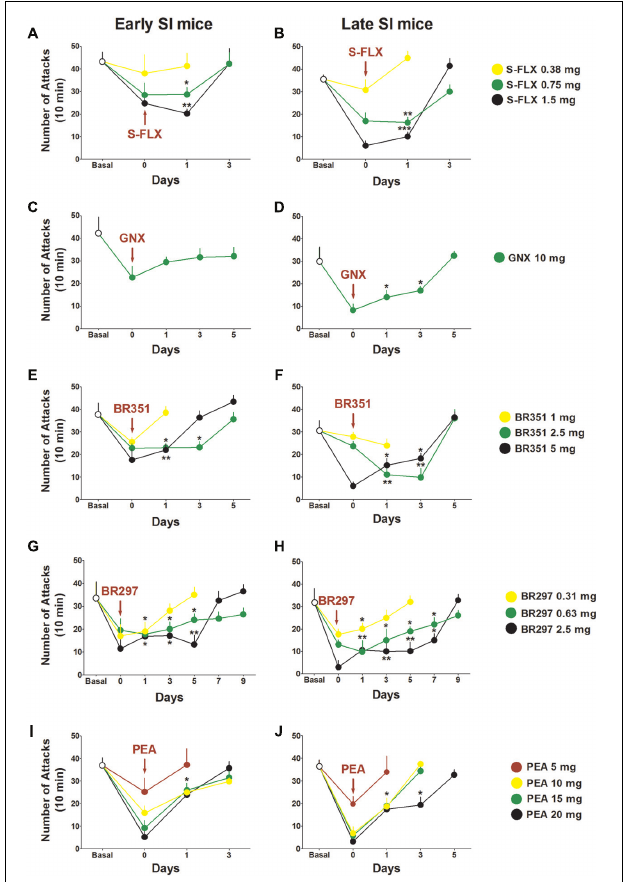
FIGURE 6 | Drug-induced time-dependent anti-aggressive effect in late and early adolescent SI mice. Graphs represent the gradual reinstatement of aggressive behavior both in early (A) and late (B) adolescent SI mice during the period following the single dose administration of S -FLX (Day 0). Aggression rapidly rebounded after 3 days from S -FLX administration in both groups of mice. After an EC 50 dose of GNX aggressive behavior rebounded to basal values only after 1 day in early adolescent (C) SI mice and after 5 days in late adolescent (D) SI mice. The gradual time-dependent reinstatement of aggressive behavior lasted 5 days in early (E) and late (F) adolescent SI mice after the administration of BR351 at the dose of 2.5 mg/kg; the duration of BR351 effect was 5 days also at the dose of 5 mg/kg in late SI mice, and 3 days in early SI mice. The anti-aggressive effect of a single dose administration of BR297 was long-lasting and required 7 days in early SI mice (G) , and 9 days in late SI mice (H) to return to basal values. Aggressive behavior was reinstated after 3 days following a single dose administration with PEA in early SI mice (I) at the doses of 10, 15, and 20 mg/kg, as well as in late SI mice (J) at the doses of 10 and 15 mg/kg. The effect of PEA at the dose of 20 mg/kg was extinguished after 5 days in late SI mice (J) . Data represent the mean ± SEM of 7–18 mice. ∗ p < 0.05; ∗∗ p < 0.01, when compared with basal control levels of aggression.